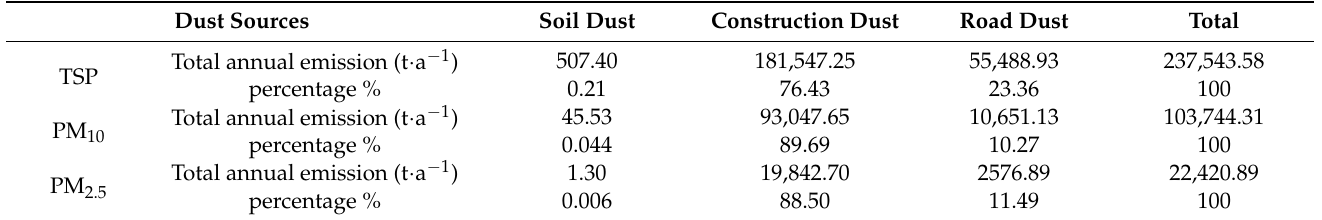
Table 4. Total emission of TSP, PM 10 and PM 2.5 from dust sources.